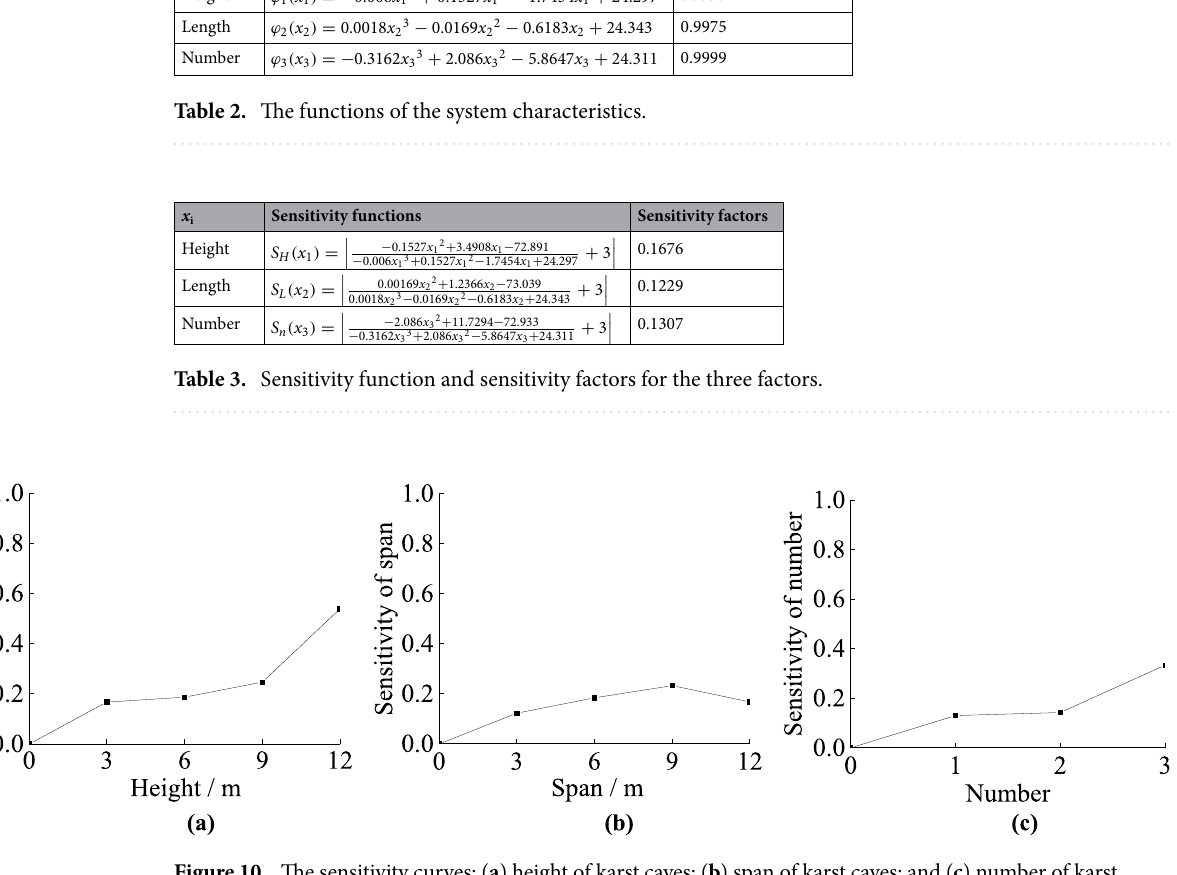
Figure 10. The sensitivity curves: ( a ) height of karst caves; ( b ) span of karst caves; and ( c ) number of karst